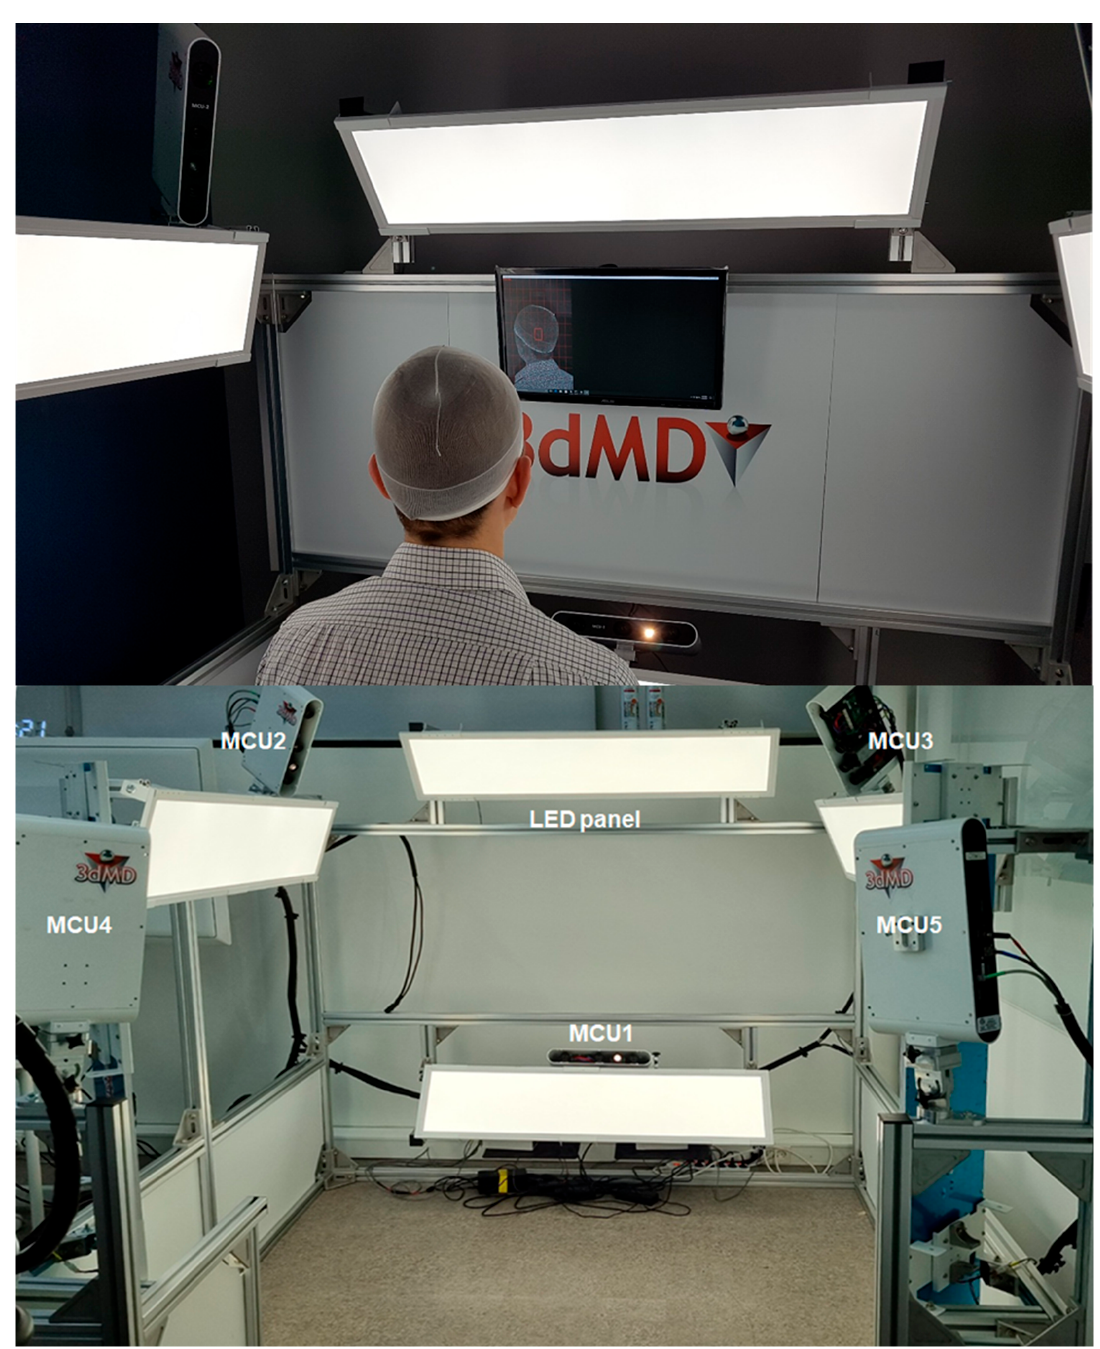
Figure 4. Three-dimensional head scanning using 3dMD.